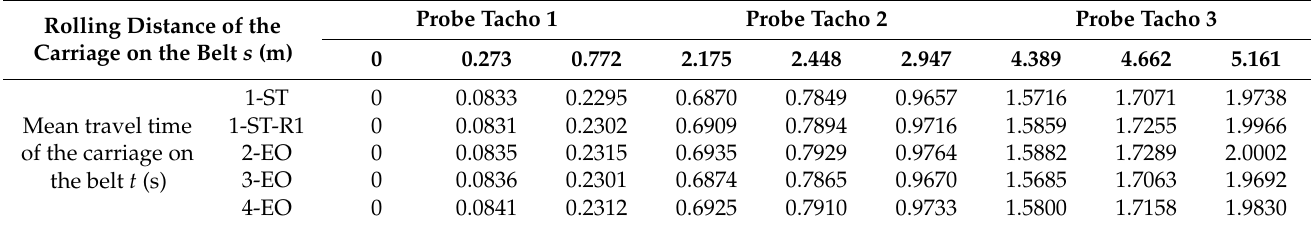
Table 2. Belt test results at a temperature of 23.0 ± 2.0 ◦ C.